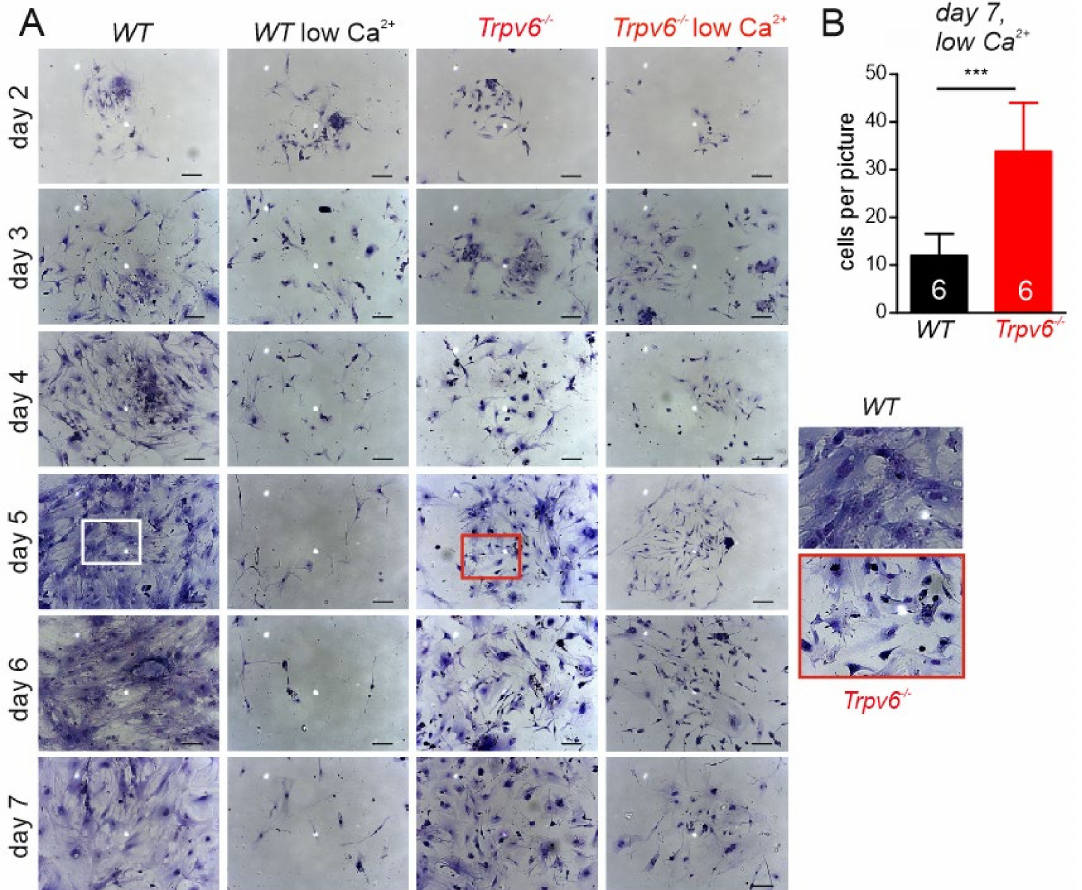
Figure 3. Primary cell culture of wt and Trpv6 - / - trophoblasts (E14.5). ( A ) Wild-type and Trpv6 - / - trophoblasts (200,000 per dish) were cultured with medium in the presence of 1.5 mM calcium. At day 2 of cell culture the calcium concentration was reduced to 0.1 mM free calcium concentration ( wt low Ca 2 + , Trpv6 - / - low Ca 2 + ). Cells in normal or reduced calcium were cultured over seven days. Cells were fixed and stained with eosin / azur stained. Scale bar: 100 µ m. Insets (red: Trpv6 - / - , white: wt ) of stained trophoblast cells in culture at day 5. ( B ) After 7 days, cells cultured in low calcium medium were fixed, stained with eosin / azur and adherent cells were counted ( n = 6 pictures from N = 2 independent preparations). The significance of the di ff erences between wt and Trpv6 - / - was calculated using Student’s t -test (*** p < 0.001), Results are shown as mean +